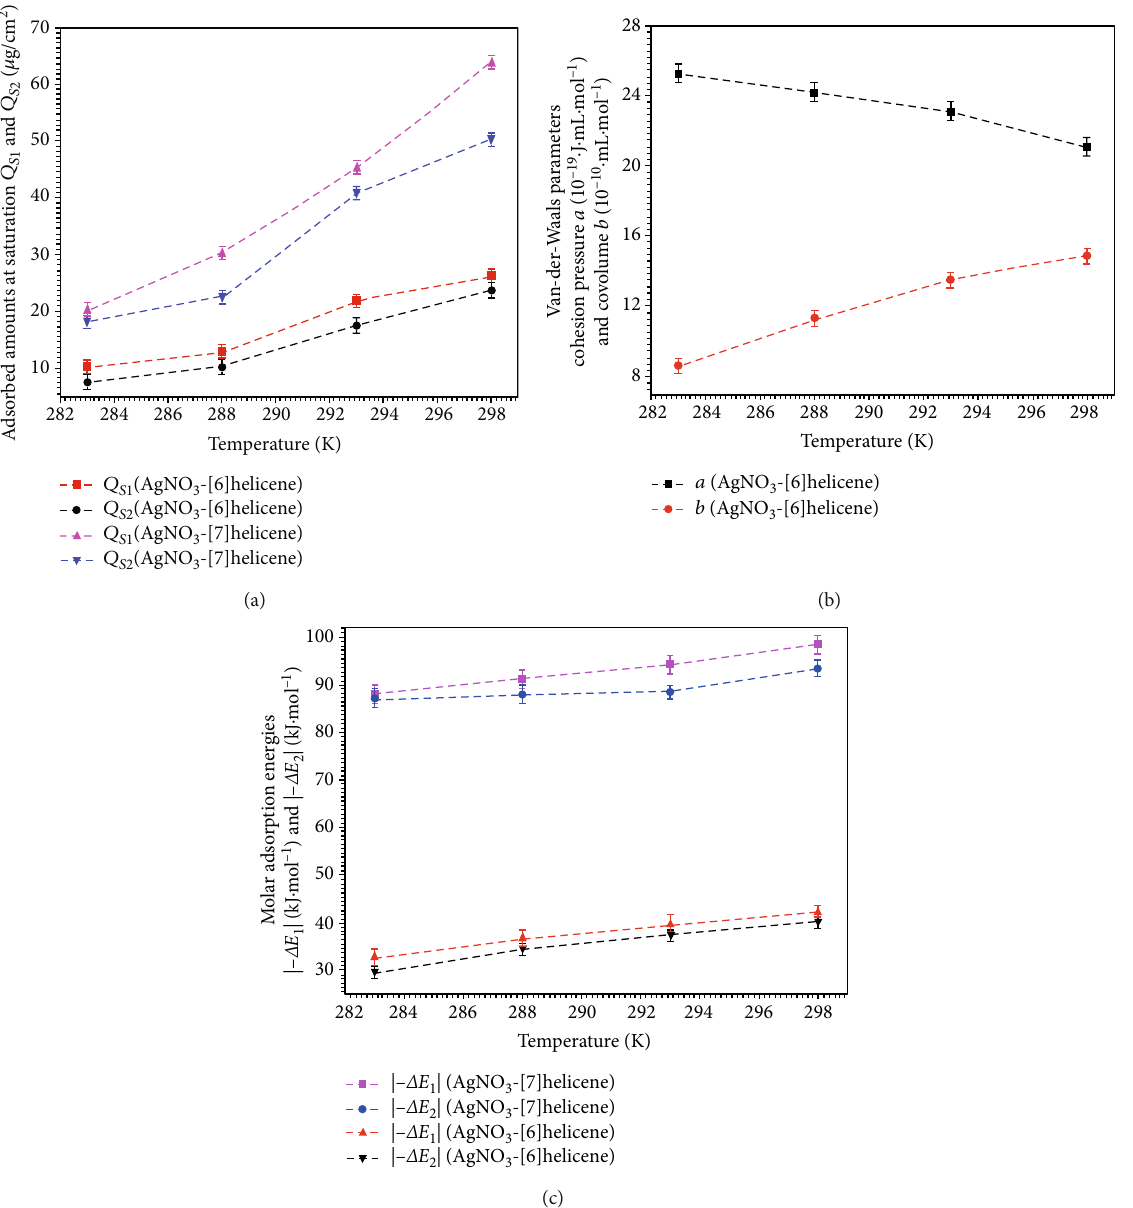
Figure 4: Evolutions of the (a) steric parameters Q (10 -10 · mL · mol − 1 ), and (c) the molar adsorption energies ( − Δ E